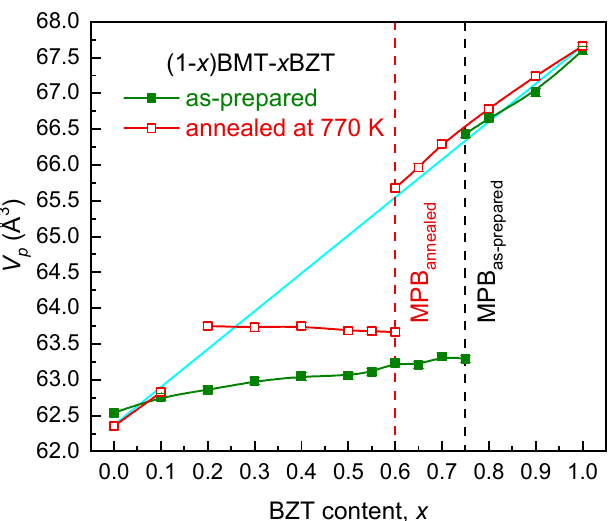
Figure 5. The normalized unit-cell volume of the (1- x )BMT– x BZT perovskite phases before and after annealing as a function of the BZT content ( x ). The error bars are smaller than the symbols. The dashed lines indicate the compositions corresponding to the morphotropic phase boundary (MPB) before and after annealing. The solid straight line is a reference to the Vegard’s law.